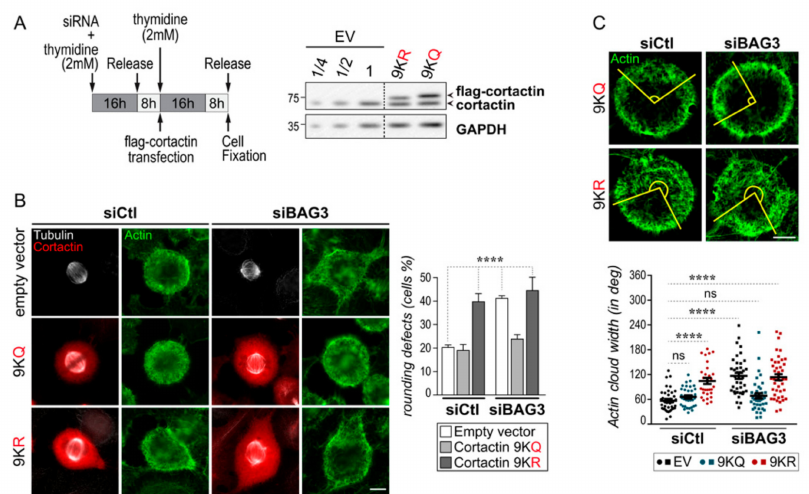
Figure 5. Acetyl-mimic cortactin-9KQ can normalize mitotic cell rounding and actin cloud organization in BAG3-depleted cells. ( A ) Schematic of the protocol. Representative Western blots showing the expression of cortactin-9KR and cortactin- 9KQ mutant after transfection in HeLa cells; GAPDH: loading control. EV: empty vector. ( B ) Representative deconvolved epifluorescence images showing the mitotic rounding phenotypes induced by cortactin mutants. The graph depicts the percentages of cells with defects in mitotic cell rounding; means ± SEM of at least 609 cells from 3 experiments. Statistical analysis was performed by the chi-square test ****, p < 0.0001. ( C ) Representative confocal images showing the organization of the actin cloud; the angular widths are delineated by yellow lines. Scale bar: 10 µ m. The graph shows the actin cloud angular widths in fixed cells stained with fluorescent phalloidin; data are the means ± SEM of n ≥ 33 cells; N = 3 experiments. Statistical analysis was performed using by the Kruskal–Wallis test and ****, p <